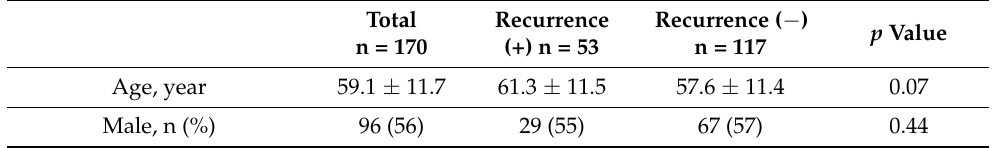
Table 1. Comparison of the demographic and clinical parameters between study